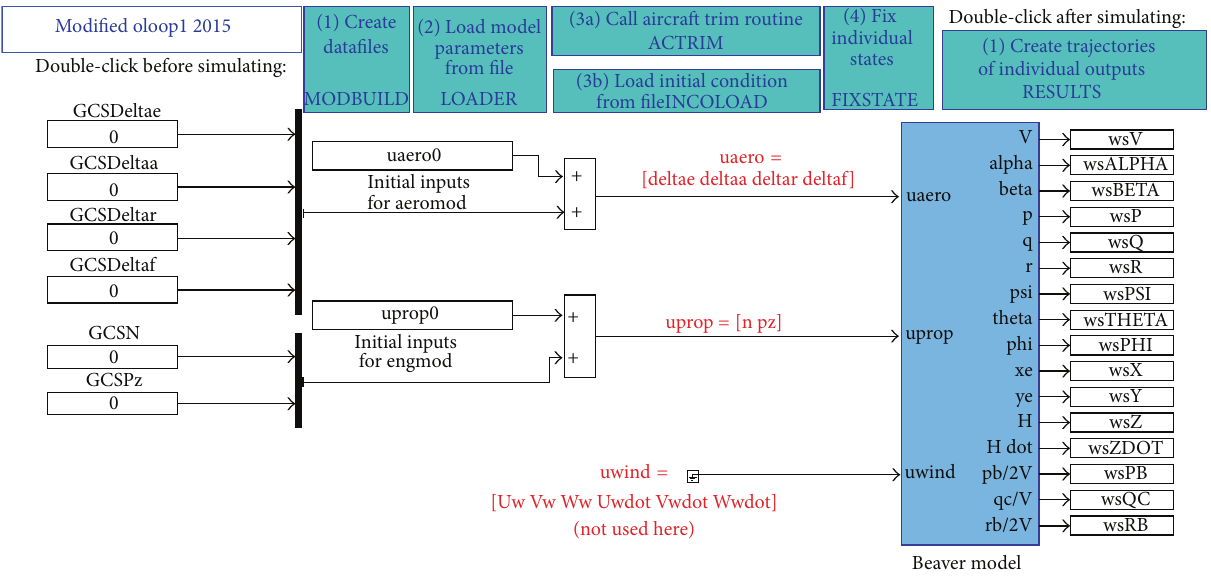
Figure 6: Modified “oloop1” simulation model for hybrid environment integration.